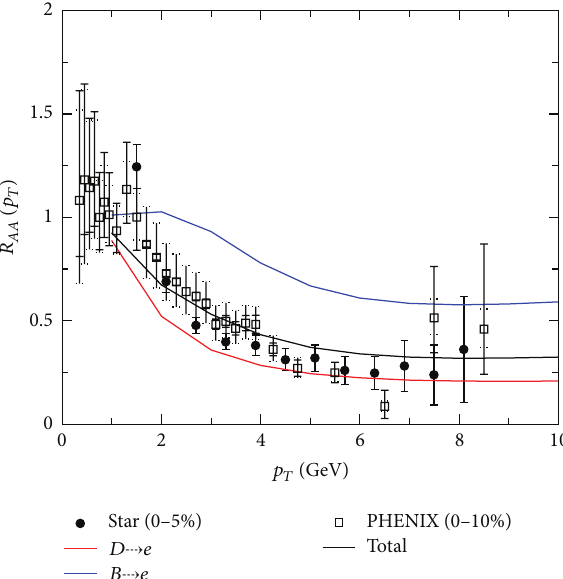
Figure 7: Variation of 𝑅 𝐴𝐴 with 𝑝 𝑇 for the space time evolution with initialcondition 𝑇 𝑖 = 250 MeVand 𝜏 𝑖 = 0.84 fm/candtheEoSwhich includes the variation of 𝑐 𝑠 with 𝑇 (colour